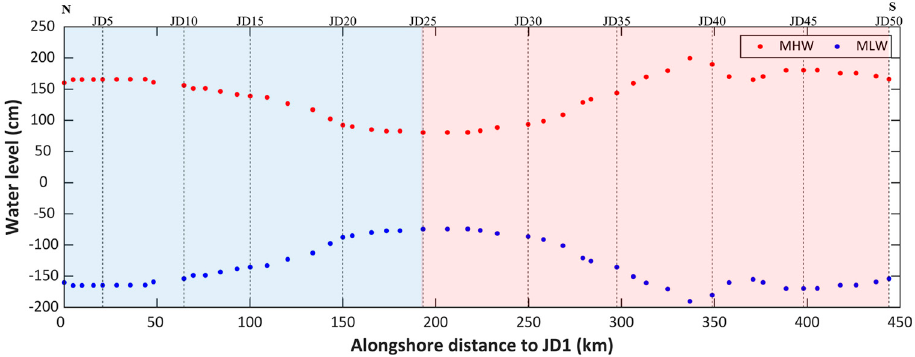
Figure 3. Interpolated mean high water (MHW) and mean low water (MLW) at each profile (the vertical dash lines indicate the location of every fifth profile; N denotes North and S denotes South and these are the same for the following figures).